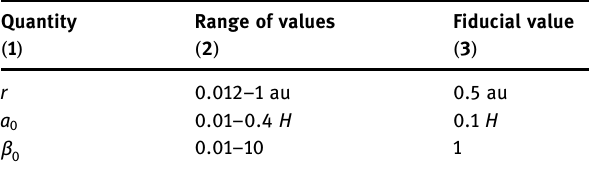
Table 1: Model parameters: radial distance from the star, initial cross - section radius, and plasma beta of the MFT